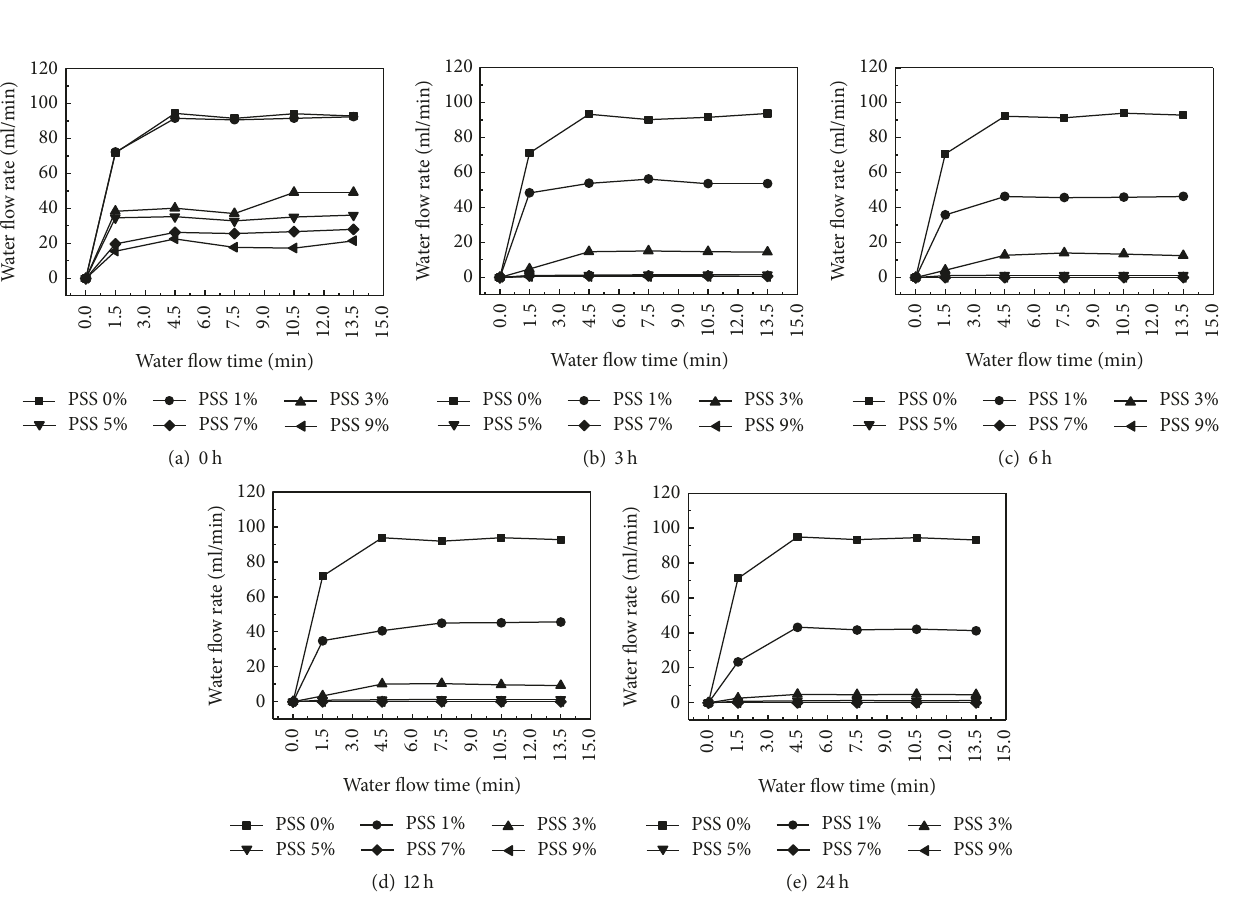
Figure 8: Water flow rate ( 𝐹 ) of specimens reinforced using different PSS concentrations at (a) curing time of 0h (b), curing time of 3 h, (c) curing time of 6h, (d) curing time of 12 h, and (e) curing time of 24 h.